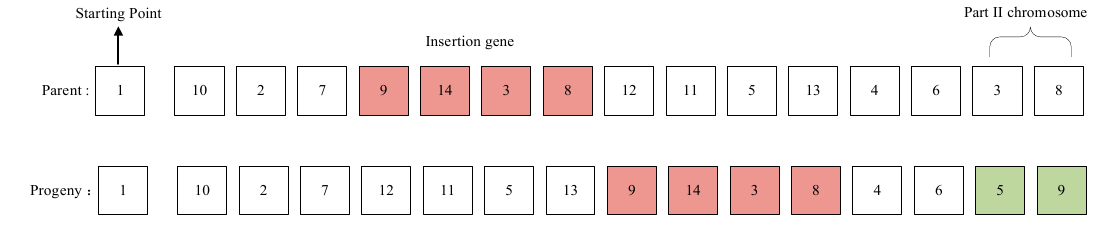
Figure 8. Insertion mutation operation ( m = 14).